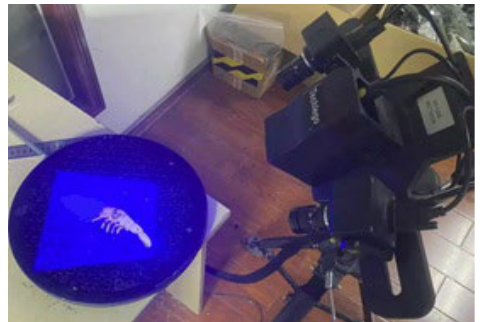
Figure 14. The 3D scanner.